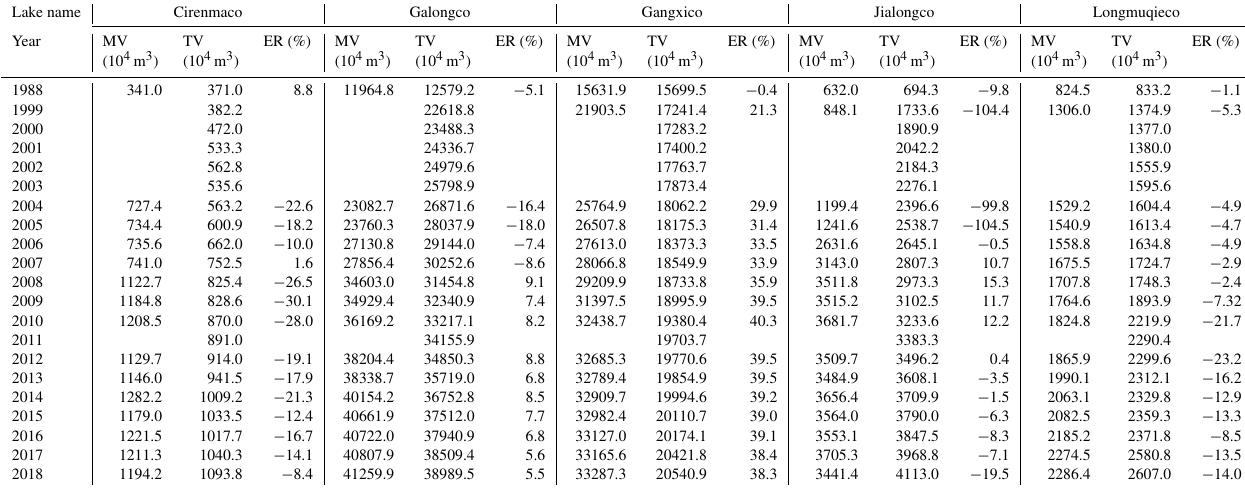
Table 12. Comparison between the calculated water quantity and the observed quantity. Lake name